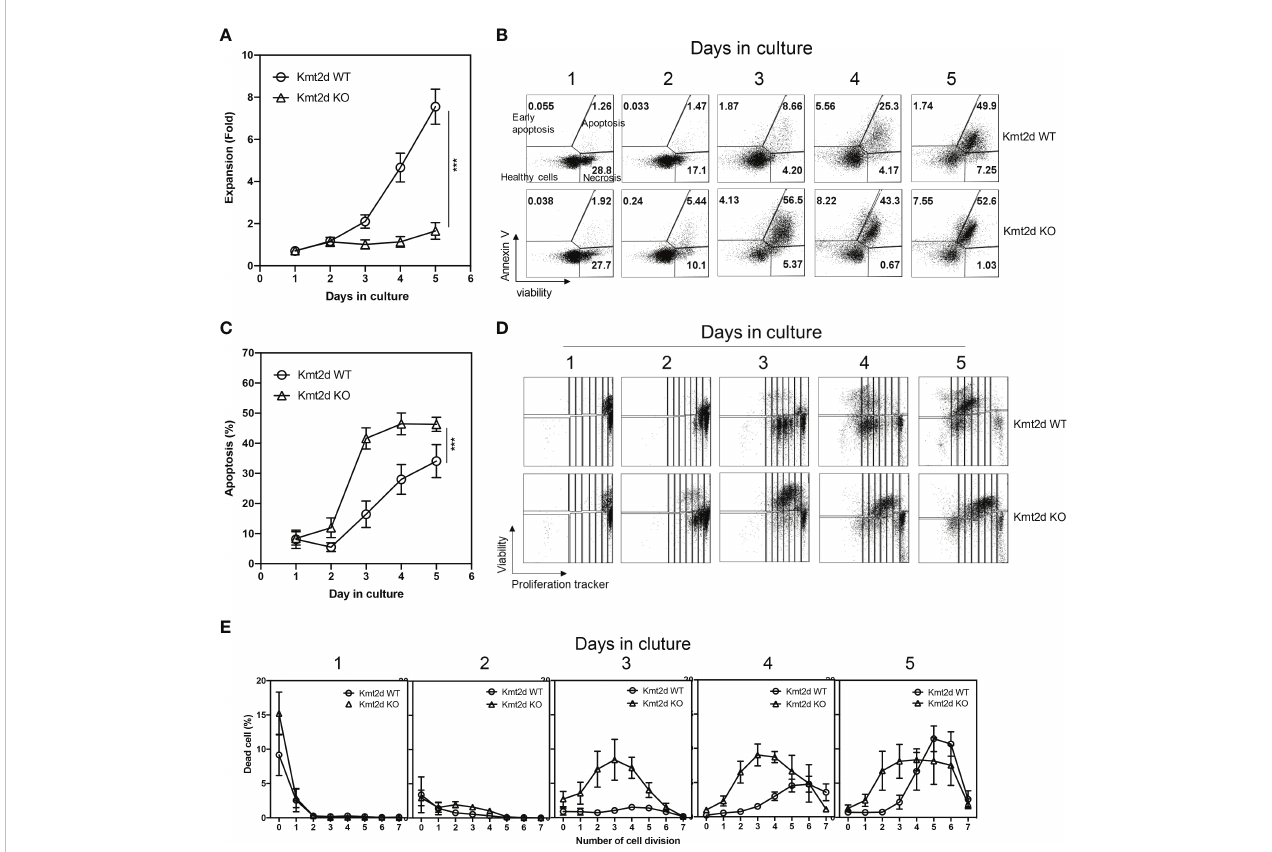
FIGURE 2 Kmt2d KO naïve CD8 + T cells have increased apoptosis upon stimulation driven proliferation. FACS-sorted naïve CD8 + T cells from spleen were labeled with proliferation tracking marker and stimulated with immobilized anti-CD3 (3 m g/ml) and soluble anti-CD28 (1 m g/ml) antibodies up to fi ve days. Three batches of independent experiments were performed with pooled naïve CD8 + T cells from 3-6 mice (N=9 for Kmt2d WT, 6 for Kmt2d KO). (A) Cell number increase during 5 days of culture. Fold increase per seeded cell number was presented. (B) Representative plot of apoptosis analysis. (C) Average apoptotic cell ratio. (D) Representative display of proliferation tracker (e fl uor450) dilution and Ghost viability dye. (E) Summary of the dead cells ratio found on each division de fi ned by e fl uor450 dilution and Ghost viability dye. ***, p<0.001 based on two-way Anova